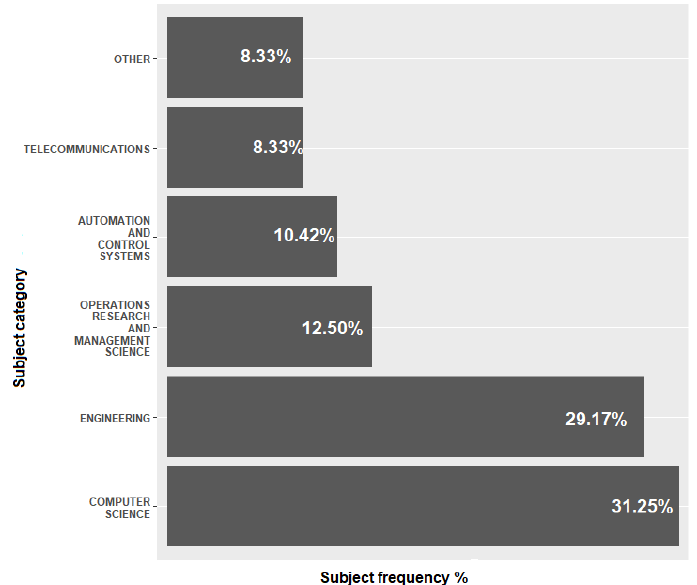
Figure 5. Percentage of publications by subject category. Bar chart with each bar representing a subject category. Size of the bar implies percentage of publications included in the